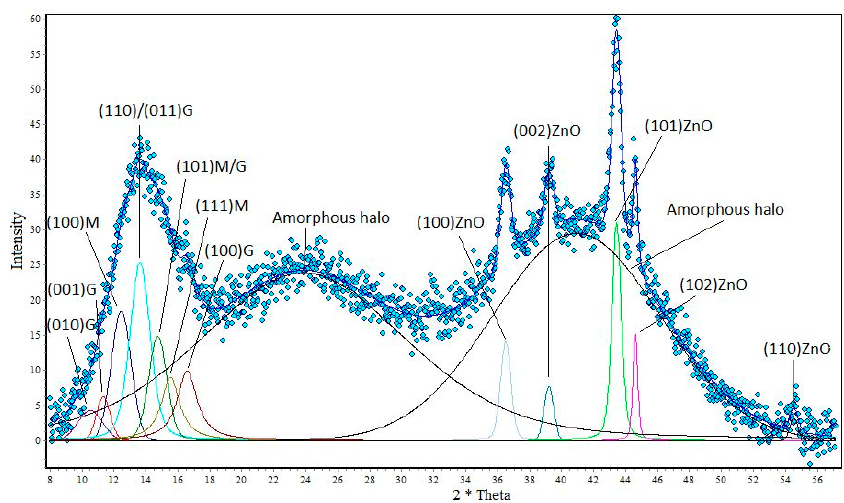
Figure 4. Distribution of the diffraction curve of calcium alginate fibers containing 2% ZnO.